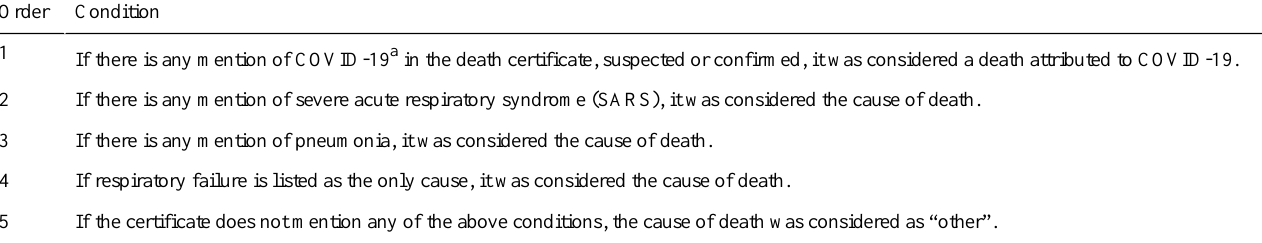
Table 1. Conditions established by the Transparency Portal of Civil Registry to classify deaths. ConditionOrder